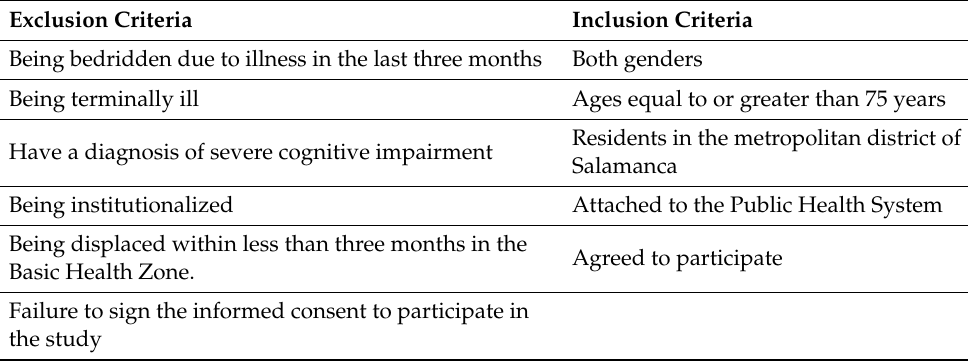
Table 1. Exclusion and inclusion